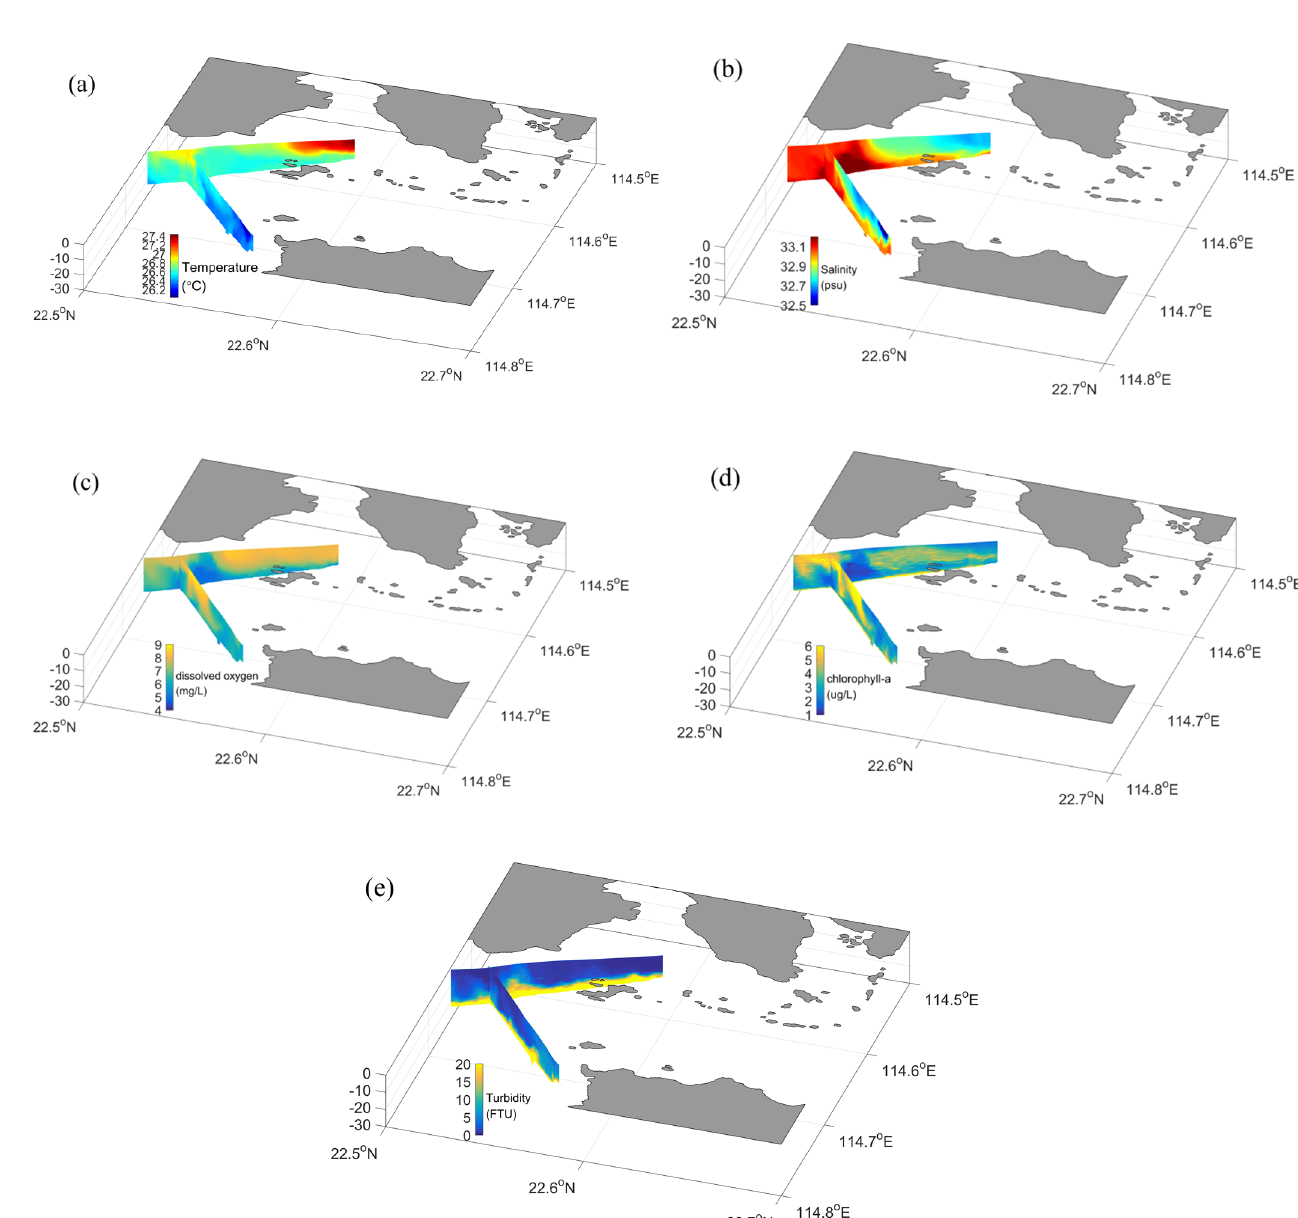
Figure 7. Three-dimensional view of ( a ) temperature, ( b ) salinity, ( c ) chlorophyll-a, ( d ) dissolved oxygen, and ( e ) turbidity distributions.